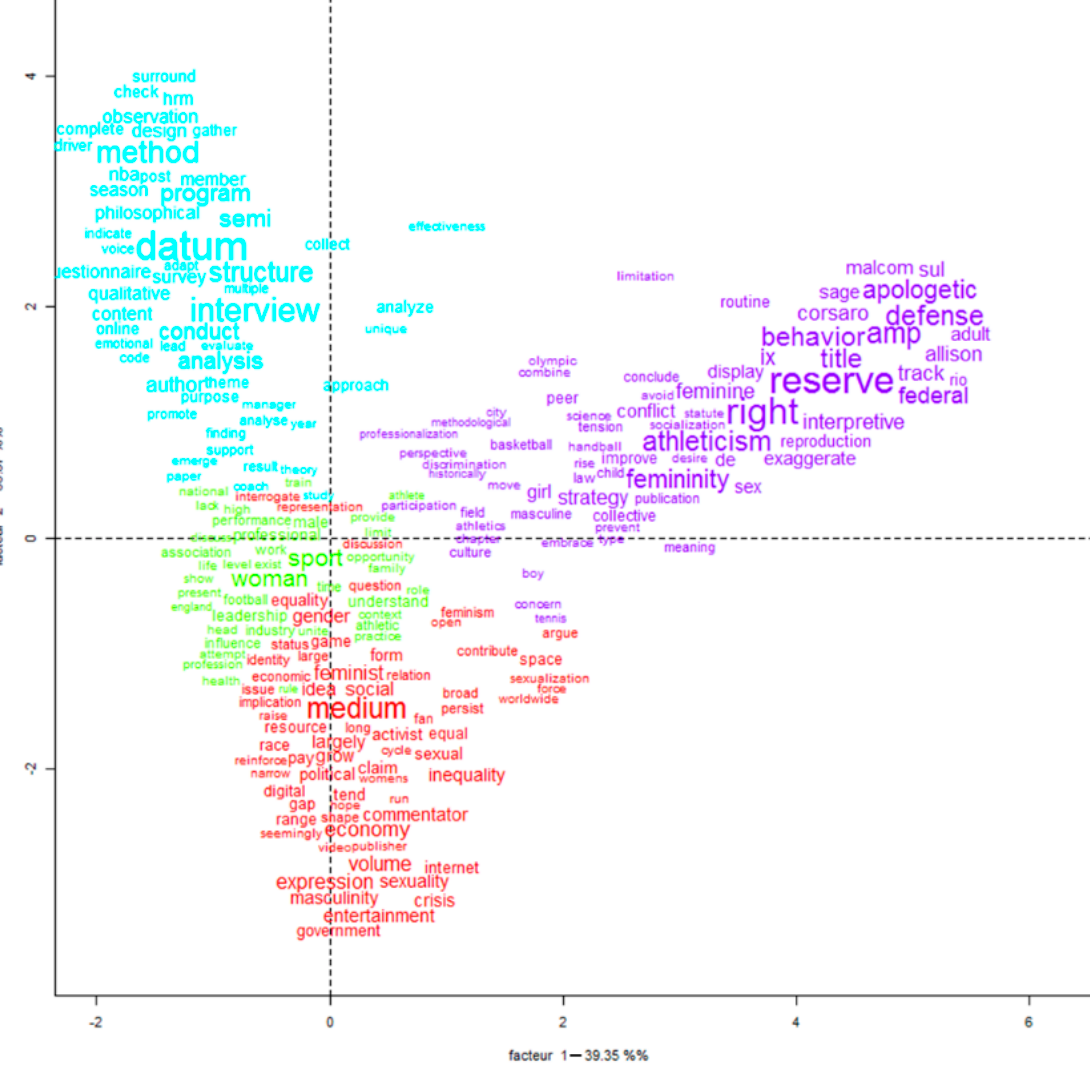
Figure 9. SRL of the professionalization of women’s sport using CFA.